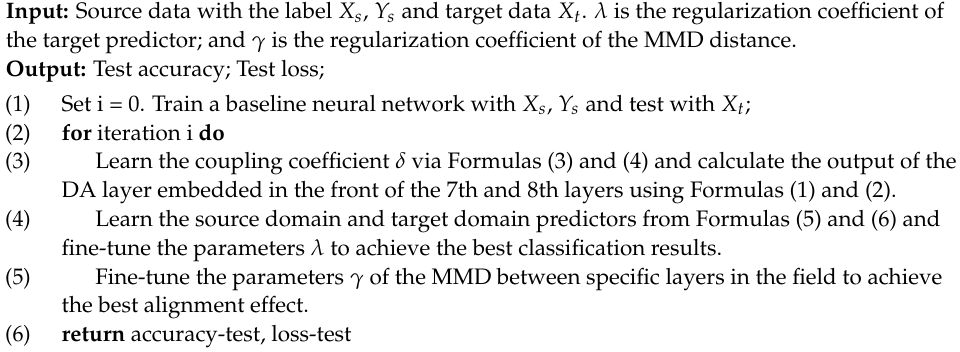
Algorithm 1: Deep transfer Learning Based on Automatic Domain Alignment and Moment